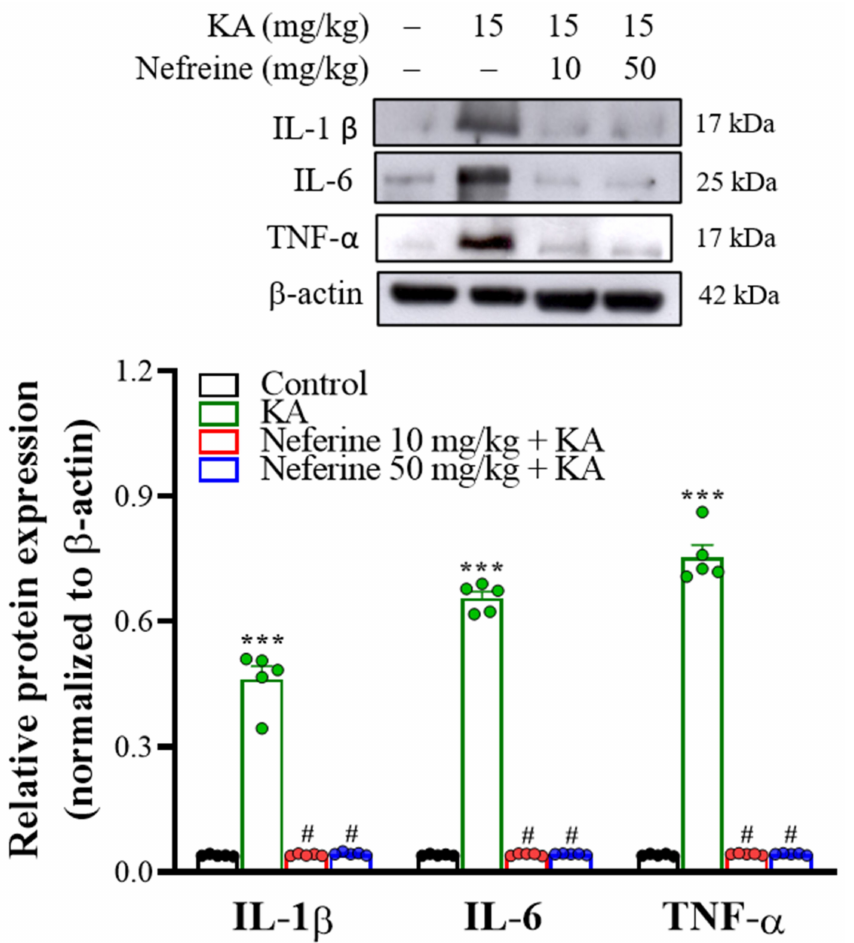
Figure 6. Neferine affects proinflammatory cytokine production in rat hippocampal tissue. Repre- sentative Western blot images in the different groups and densitometric values for IL-1 β , IL-6, and TNF- α were normalized to β -actin levels ( n = 5 rats/group). Statistical results of immunoblot analysis showed that neferine reduced the band intensities of IL-1 β , IL-6, and TNF- α (one-way ANOVA). *** p < 0.05 vs. control group. # p < 0.05 vs. KA-treated